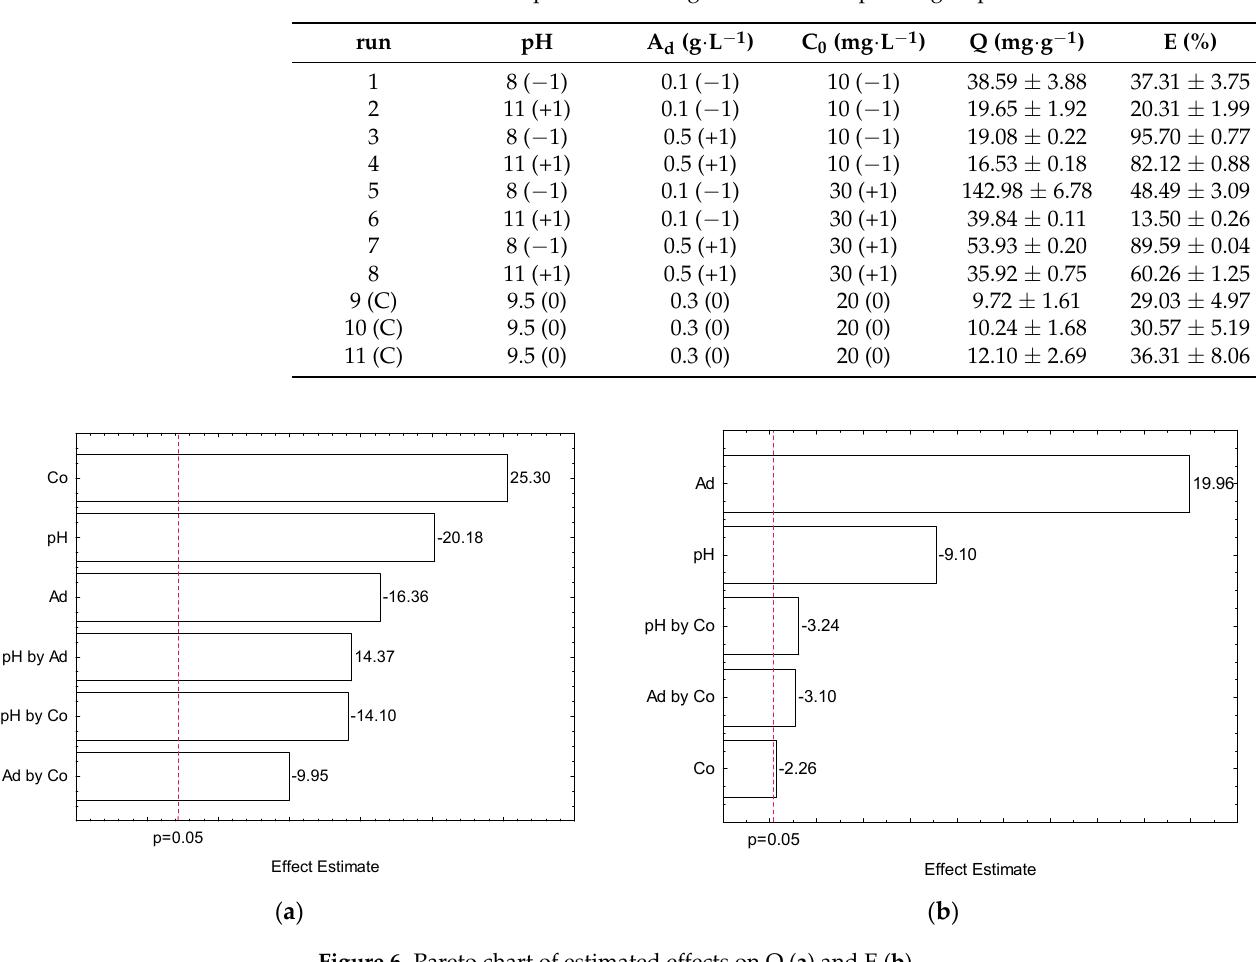
Table 3. Matrix of the experimental design and the corresponding responses.